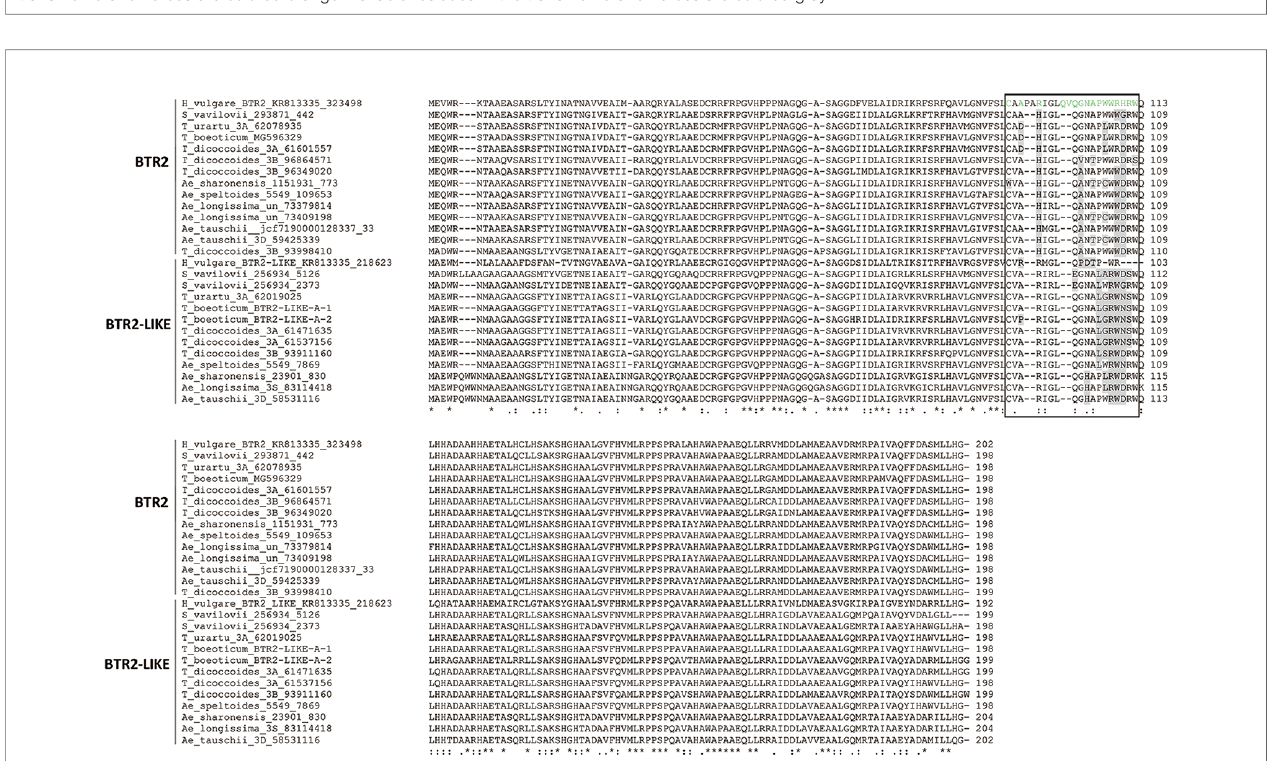
FIGURE 5 | Alignment of deduced Triticeae BTR2 and BTR2-like polypeptides. The CAR-PIP motif region is shown boxed and the motif present uniquely in barley is colored green. Variable residues in the motif region are colored gray.